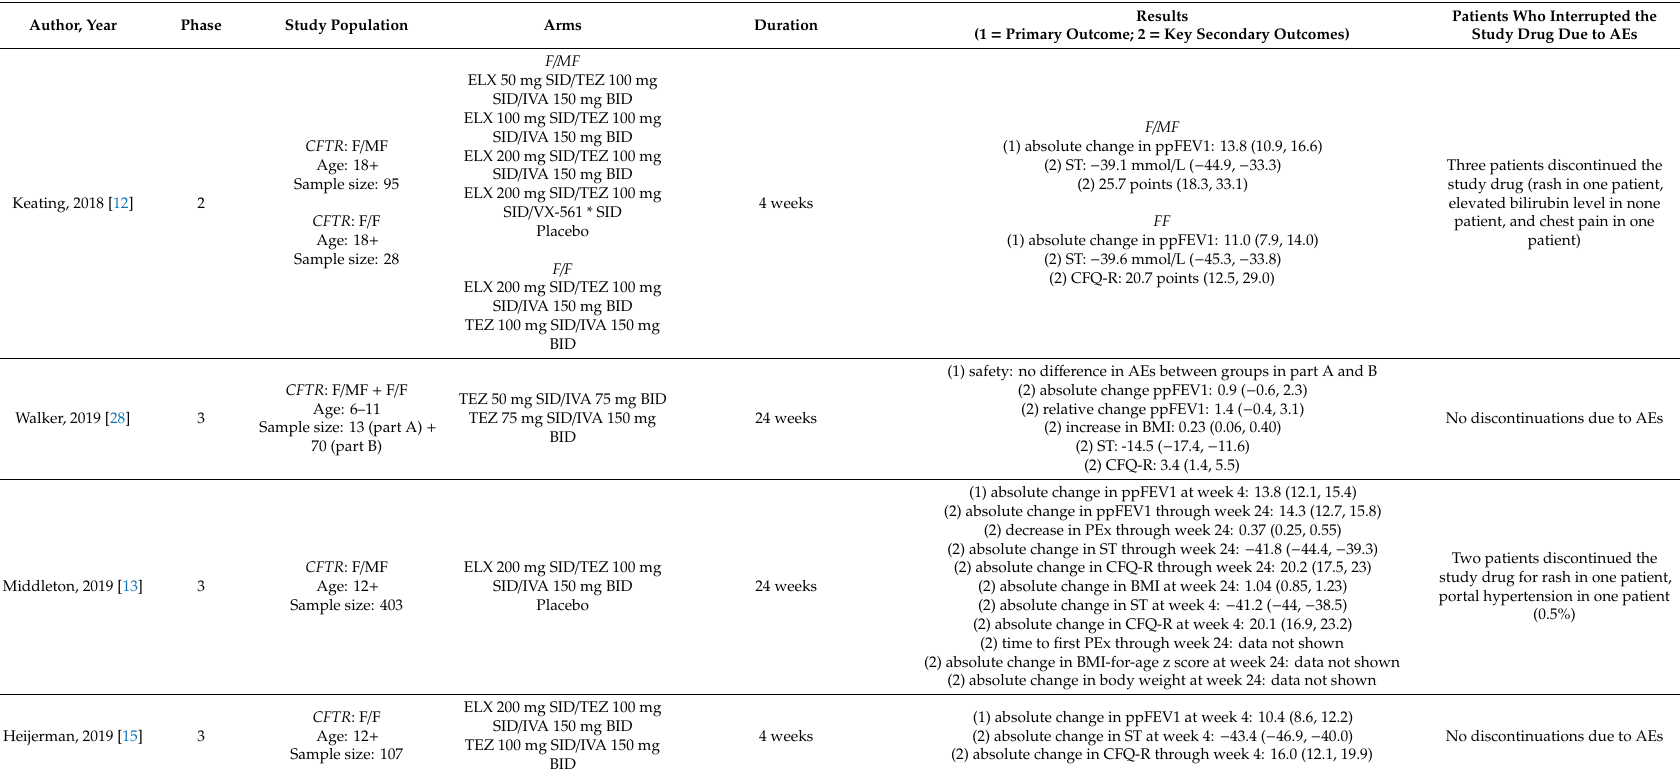
Results (1 = Primary Outcome; 2 = Key Secondary Outcomes)